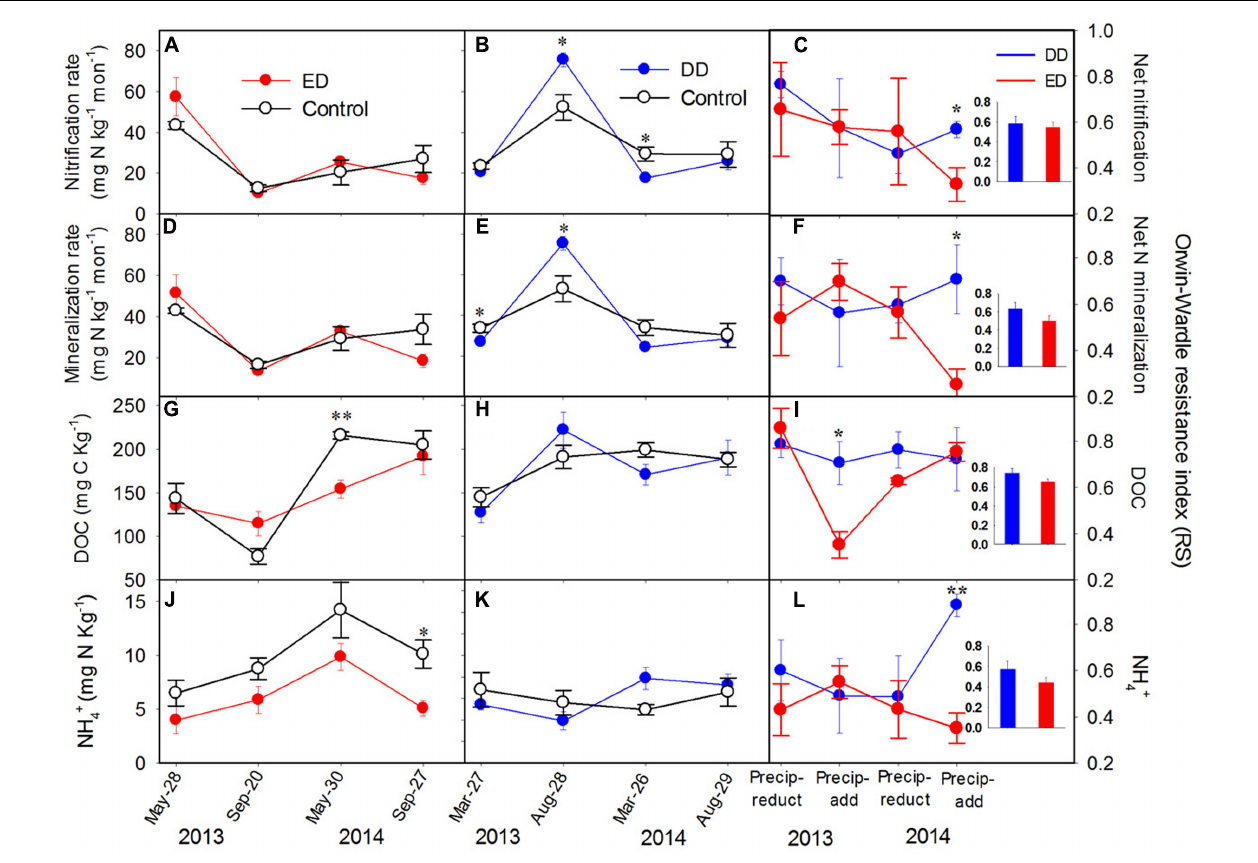
FIGURE 1 | Dynamics of (A–C) net nitrification rate, (D–F) net N mineralization rate, (G–I) soil dissolved organic carbon (DOC) content, and (J–L) NH 4 + concentrations in the control and treatment plots, and their resistance indices throughout the experiment ( n = 4). The insert bar charts represent the average values of the resistance index in each treatment during the experiment. The y -axis of the middle and left panels is presented on the left side, and the y -axis of the right panel is presented on the right side. The significance of the differences between the treatments and control at each sampling point is presented as ∗∗ p < 0.01, ∗ p < 0.05. Abbreviations: DD, dryer dry season and wetter wet season; ED, extended dry season and wetter wet season; Precip-reduct, precipitation reduction; Precip-add, precipitation